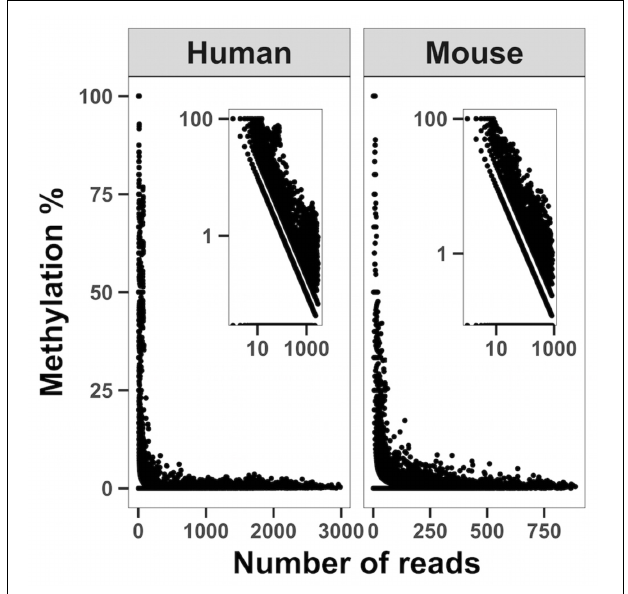
FIGURE 2 | Correlation analysis between sequencing depth and cytosine unconversion rate. WMGBS shows an inverse relationship between mtDNA cytosine unconversion rate (Methylation %) and sequence depth (Number of reads) in both human and mouse cells. Log log scales are shown in the upper right corner. The correlation coefficient is R = –0.907, P < 2.2E-16 and obtained by pooling all